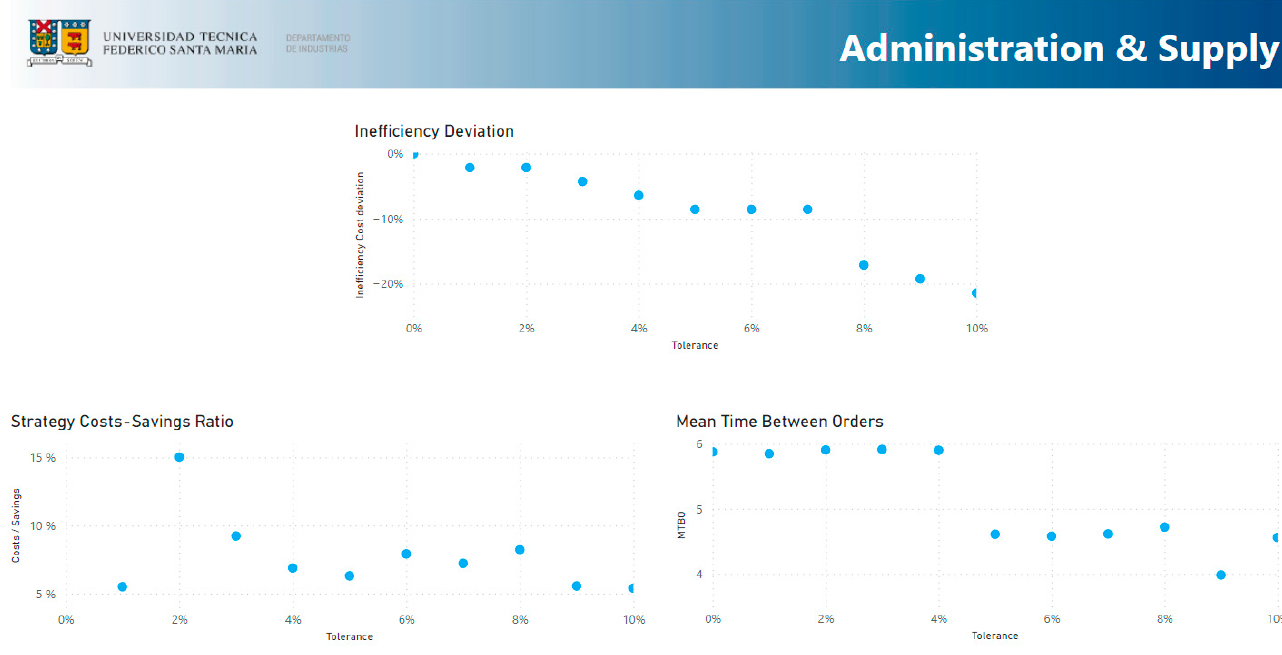
Figure 9. Administration and supply section.